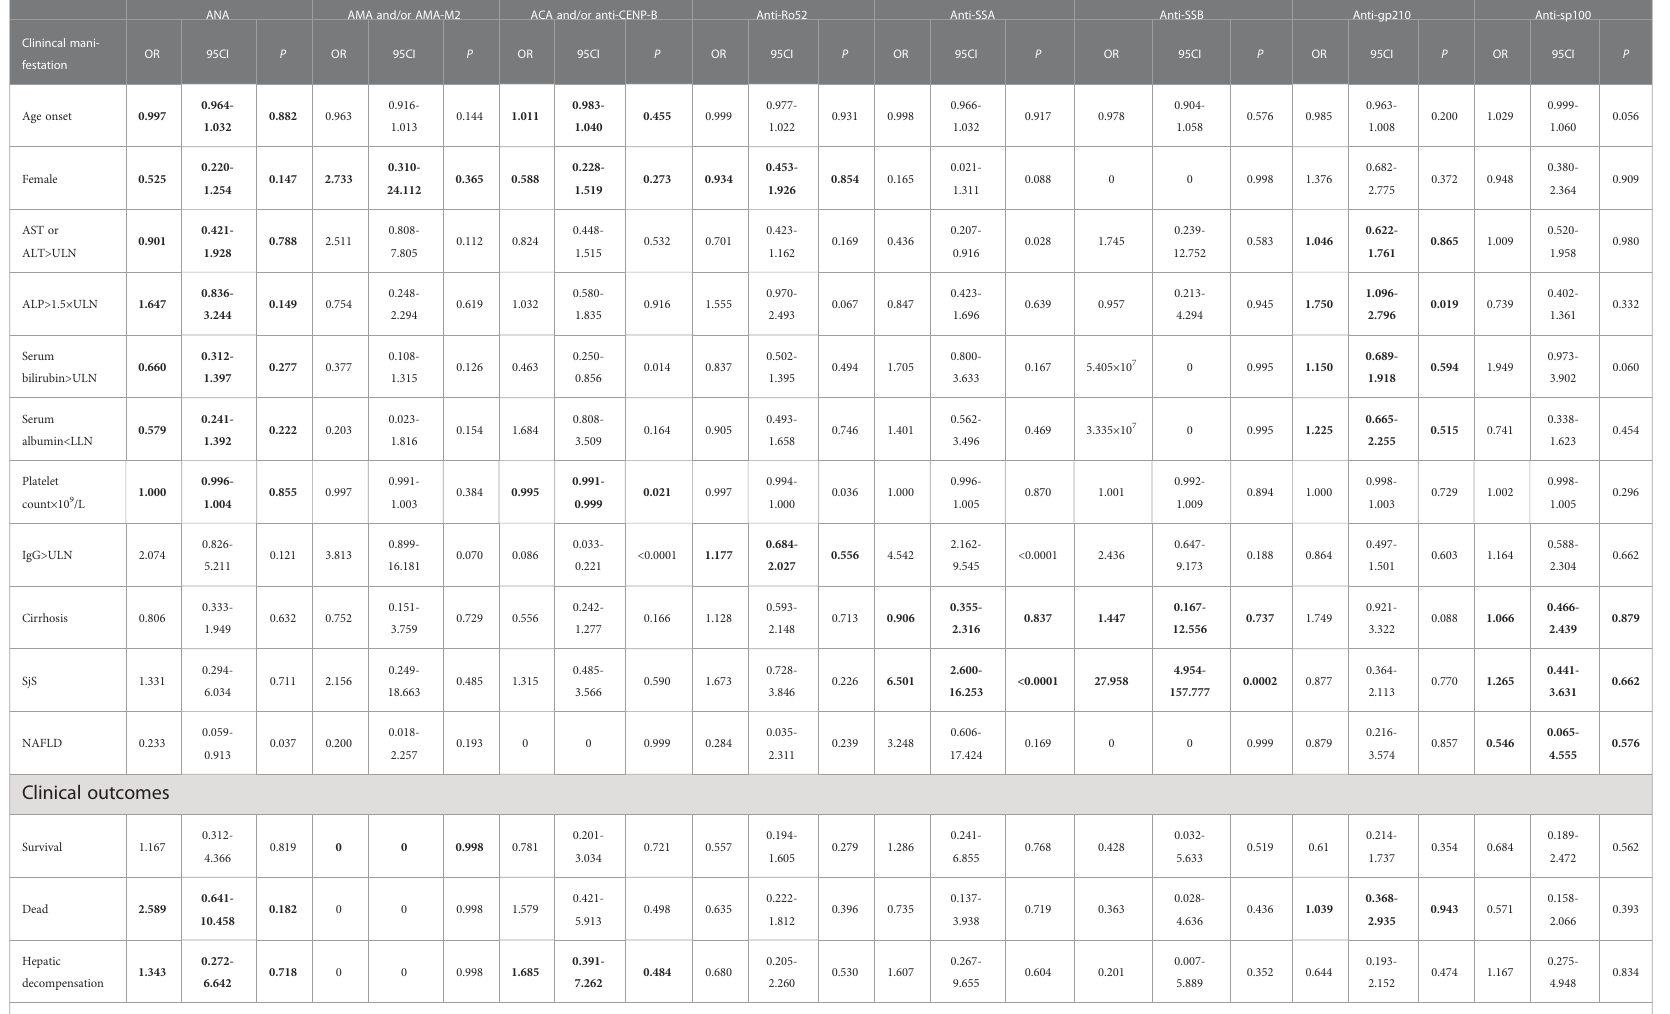
TABLE 3 Associations between individual autoantibodies, clinical features and outcomes of patients with PBC . ANA AMA and/or AMA-M2 ACA and/oranti-CENP-B Anti-Ro52 Anti-SSA Anti-SSB Anti-gp210 Anti-sp100 Clinincal mani-